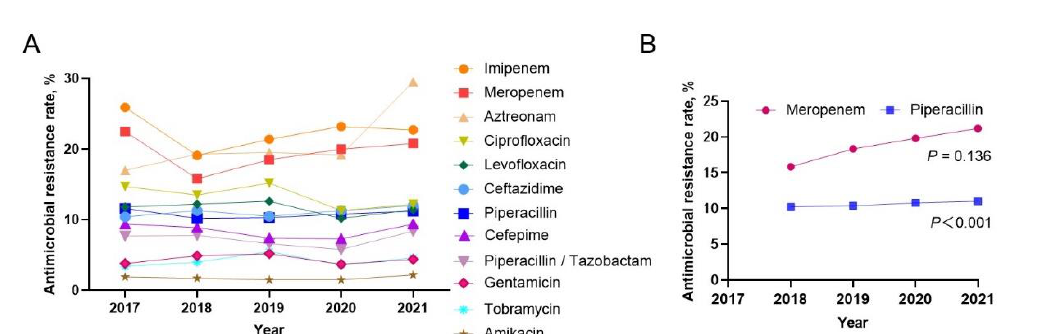
Figure 3. Annual antimicrobial susceptibility trends in P. aeruginosa from 2017 to 2021. ( A ) Changes in annual drug resistance rate of single antibacterial agents of P. aeruginosa from 2017 to 2021 (the note on the right for various antibacterial agents); ( B ). Annual resistance change of meropenem ( p = 0.136) and piperacillin ( p < 0.001) to P. aeruginosa from 2018 to 2021 (The change of drug resistance was statistically analysed by linear chi-square test, p < 0.05 indicating that the difference was statistically significant).